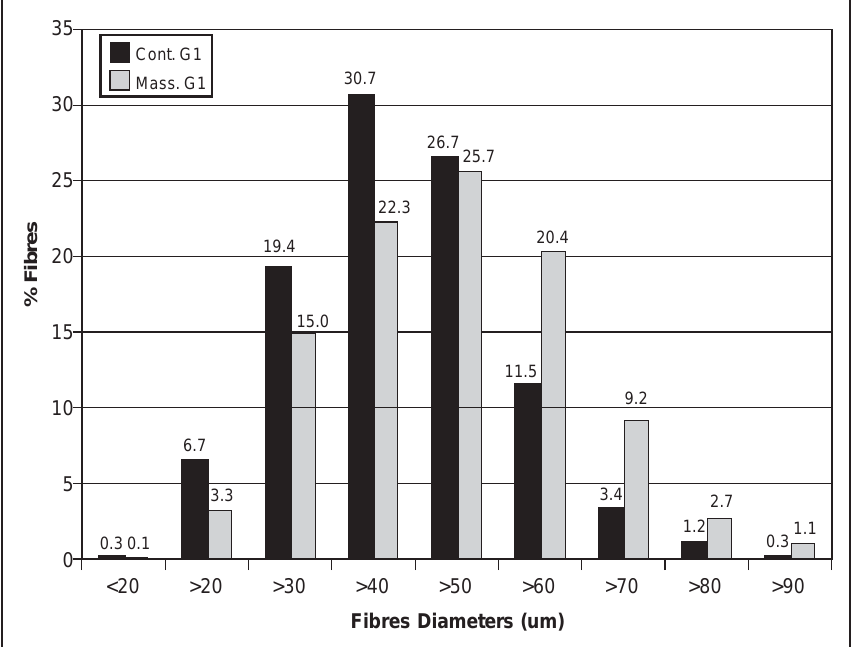
Figure 2: Frequency distribution of fibres from control (Cont. G1) and massaged muscle (Mass. G1) after one treatment of the anterior compartment.